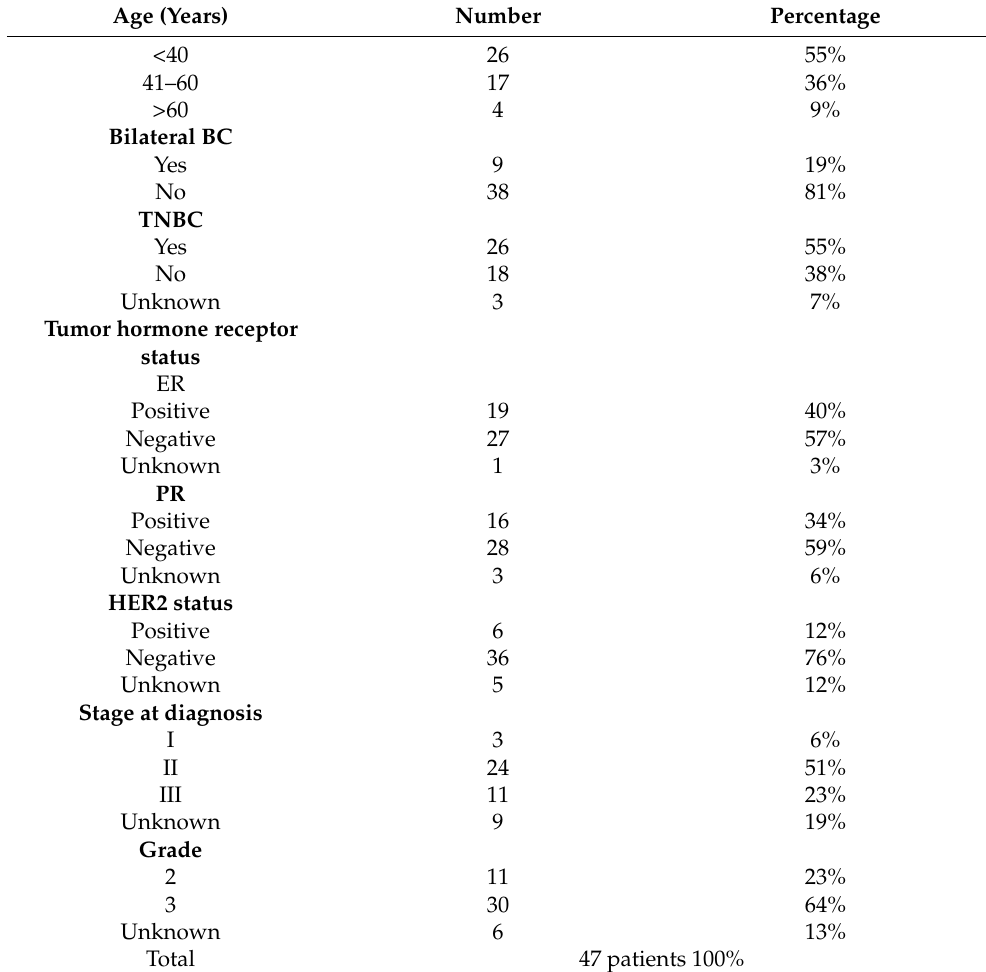
Table 1. Clinical and pathological characteristics of the 47 Romanian patients with primary BC and BRCA mutations selected by age at diagnosis and tumor